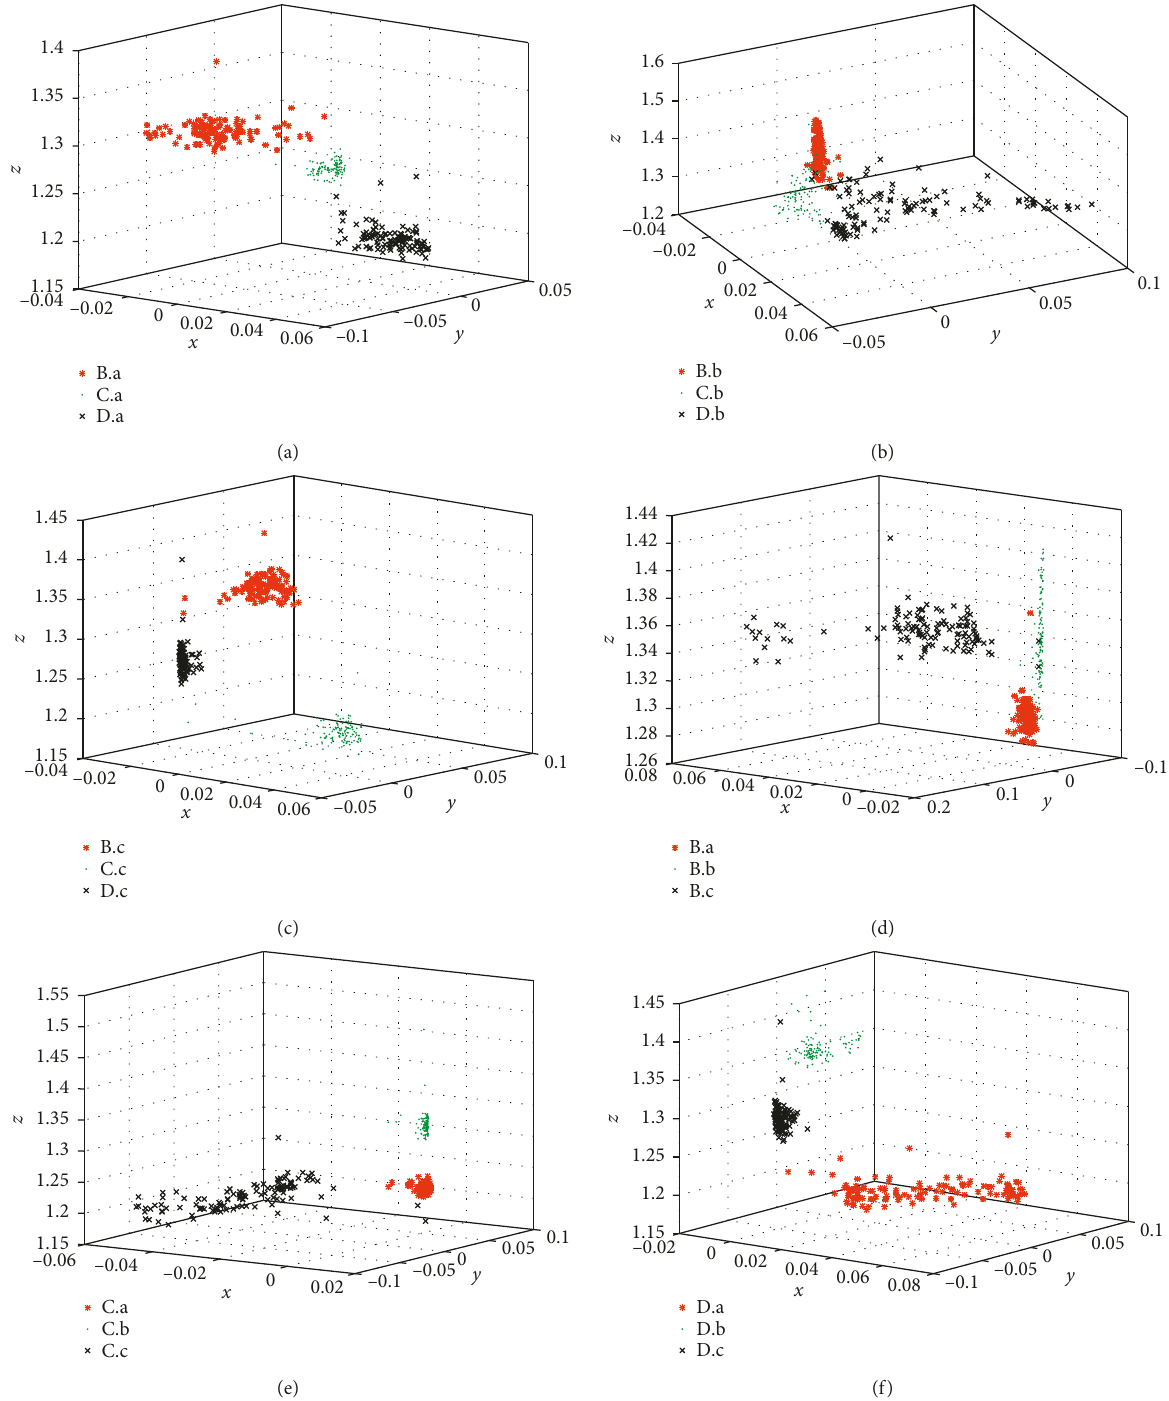
Figure 6: 3D scattered plots from fractional lower-order features proposed in this paper. (a) Fault set 1. (b) Fault set 2. (c) Fault set 3. (d) Fault set 4. (e) Fault set 5. (f) Fault set